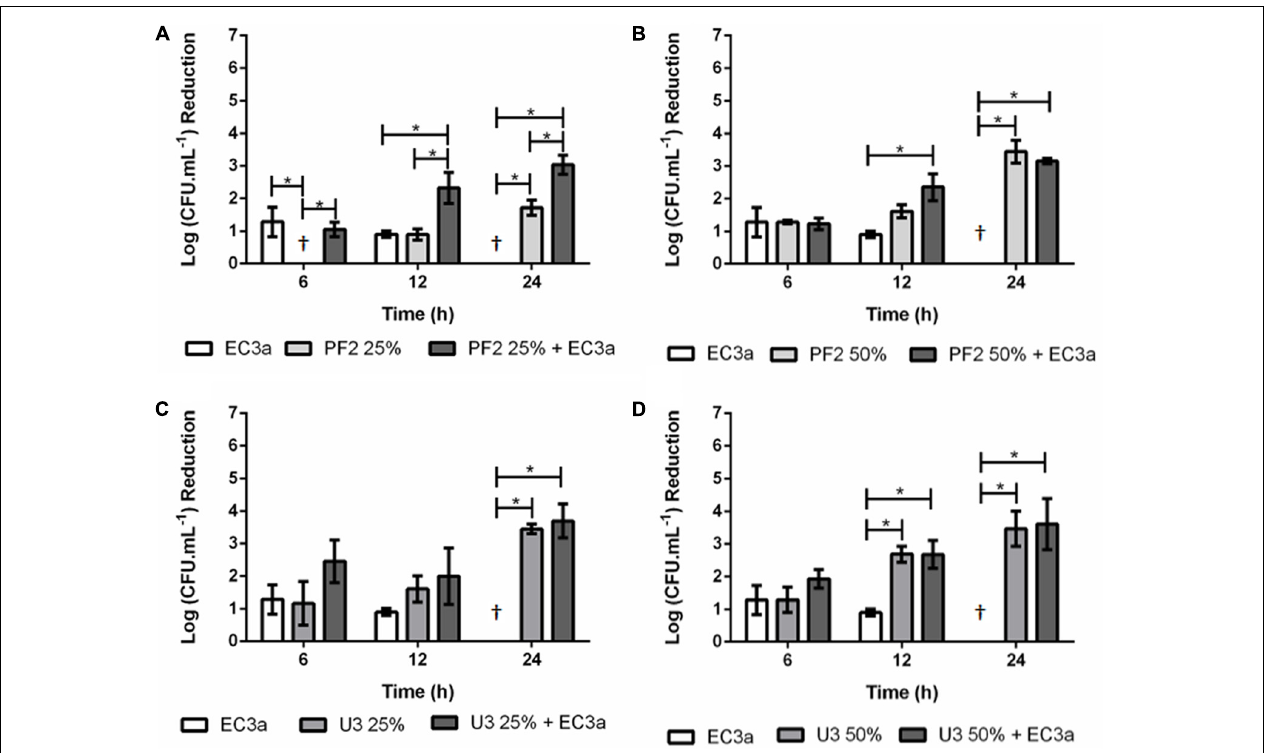
FIGURE 4 | Antibiofilm effect of phage EC3a, honey, and of the phage–honey combination on 48-h-old E. coli biofilms. (A) PF2 25% , (B) PF2 50% , (C) U3 25% , (D) U3 50% . † Values present no reductions compared to control samples. ∗ Indicates that the difference is statistically significant at the p -value < 0.05